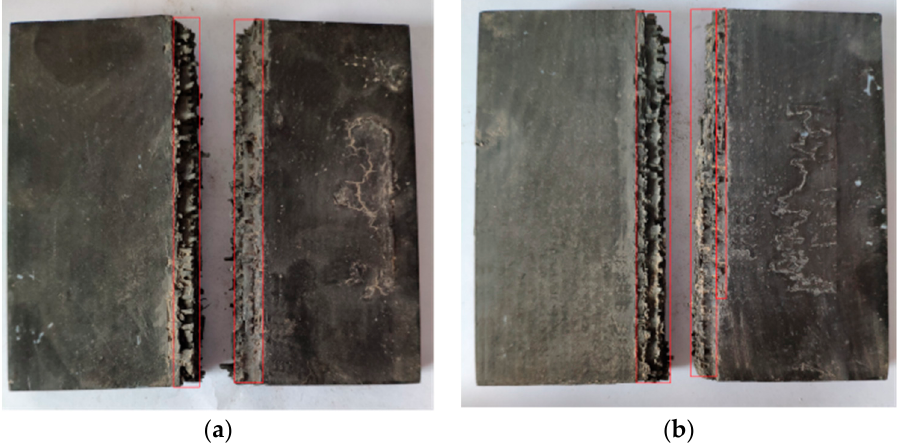
Figure 17. Schematic diagram of surface damage of laminated board. ( a ) 15 mm; ( b ) 25 mm. Table 6. Cut-off experimental data comparison.